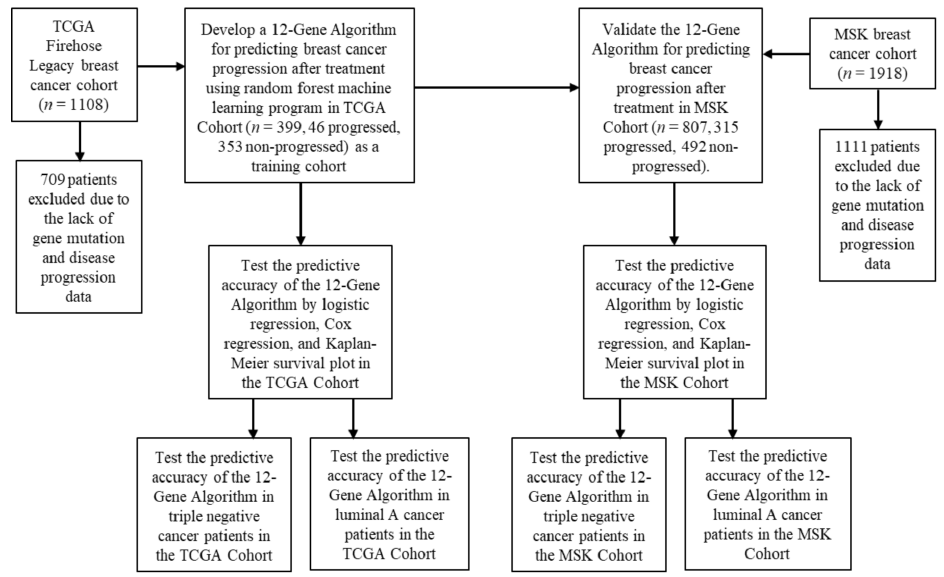
Figure 1. Study design.